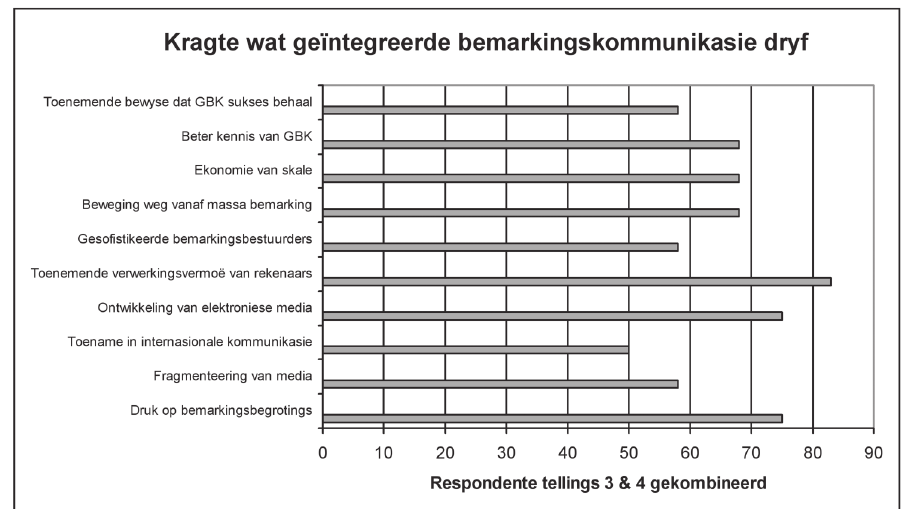
FIGUUR 1: Kragte wat geïntegreerde bemarkingskommunikasie